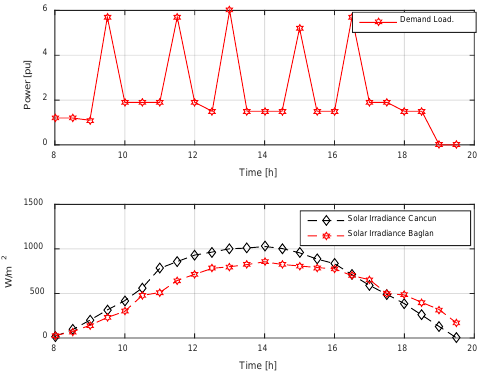
Figure 5. Forecasting curves to the microgrid Figure 5 . Forecasting curves to the microgrid test.